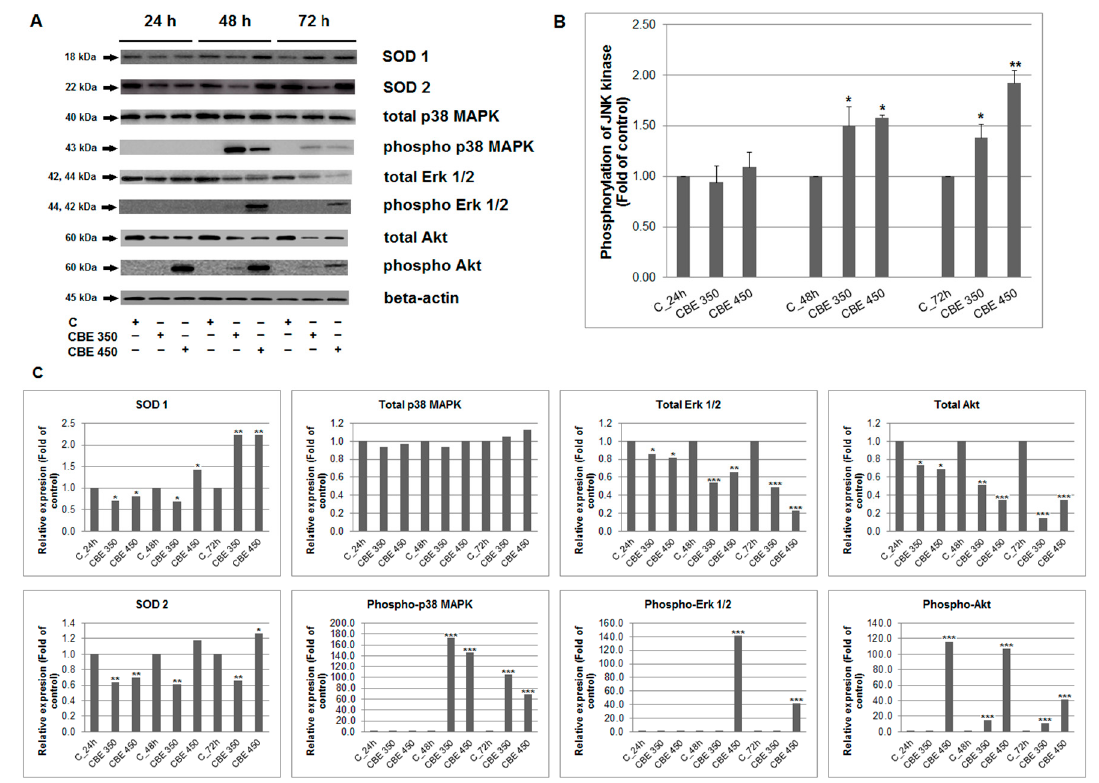
E ff ect of CBE on ( A ) protein expression, ( B ) JNK kinase activity in MCF-7 cells. ( C ) Densitometry analyses of western blot results. Representative data of three independent experiments after 24, 48 and 72 h CBE treatment are presented. Significance: * p < 0.05, ** p < 0.01, *** p < 0.001 vs. untreated cells (control).